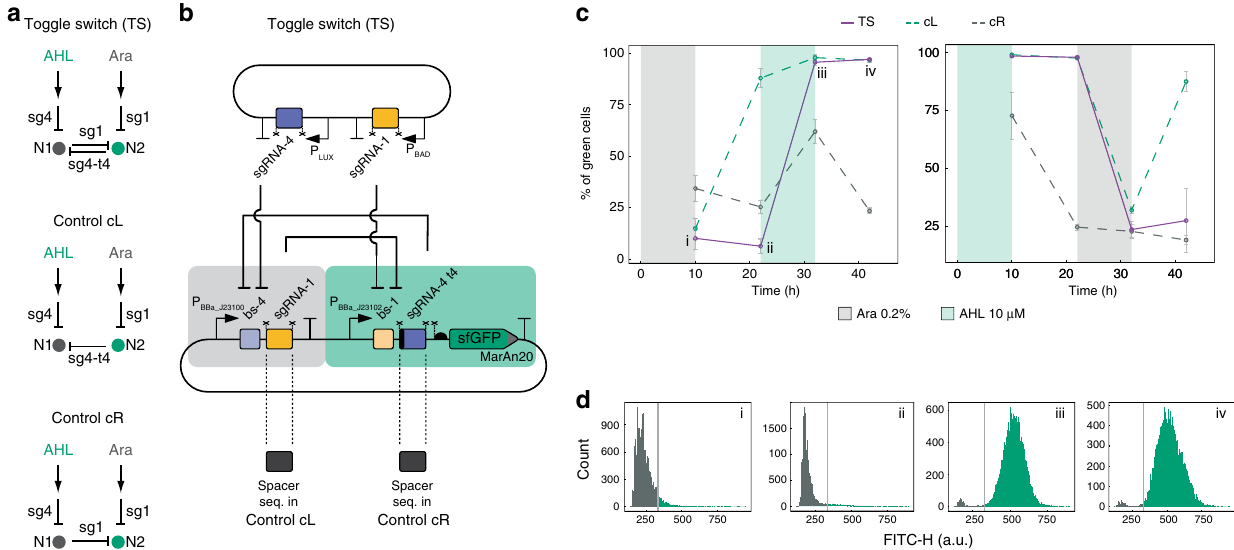
Fig. 2 The CRISPRi-based toggle switch (TS). a Topology of the bistable TS and the monostable controls. b Molecular implementation. Symbols as described in Fig. 1. c Behavior of TS and control circuits over time in response to two induction schemes: Ara-nothing-AHL-nothing (left) or AHL-nothing- Ara-nothing (right). The percentage of green cells was determined by fl ow cytometry for four biological replicates (shown are the mean and the s.d.). d Histograms showing representative distributions of the TS cells according to their green fl uorescence for the four timepoints indicated in panel c : (i) after Ara induction, (ii) after Ara followed by no inducer, (iii) after Ara-nothing-AHL, and (iv) after Ara-nothing-AHL-nothing. Black: cells below threshold for ‘ HIGH ’ state (gray line); green: cells in ‘ HIGH ’ state. Source data are provided as a Source Data fi le.